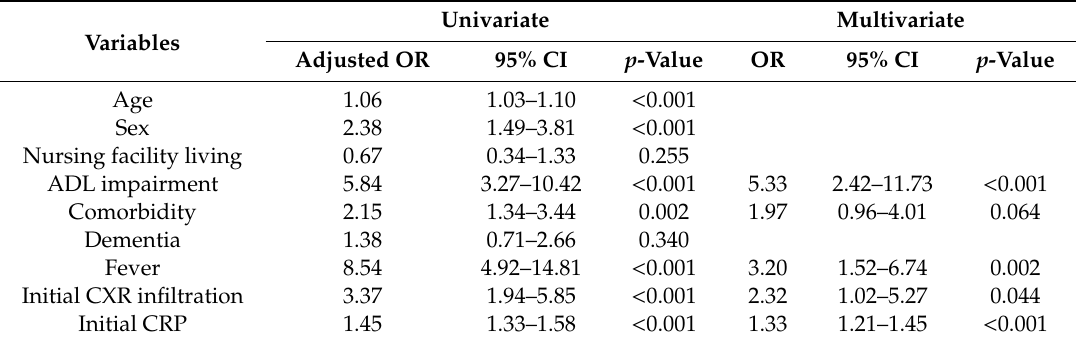
Table 3. Univariate and multivariate logistic regression analysis of predictive factors for severe pneumonia with COVID-19.